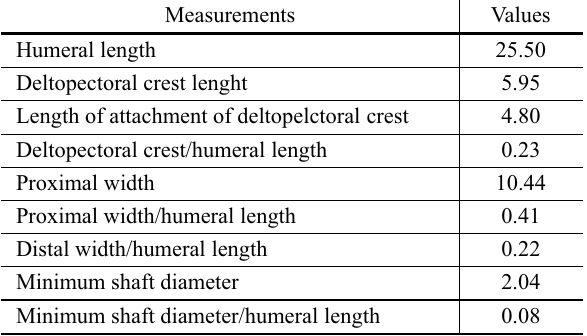
Measurements (in mm) and proportions of MB.R.